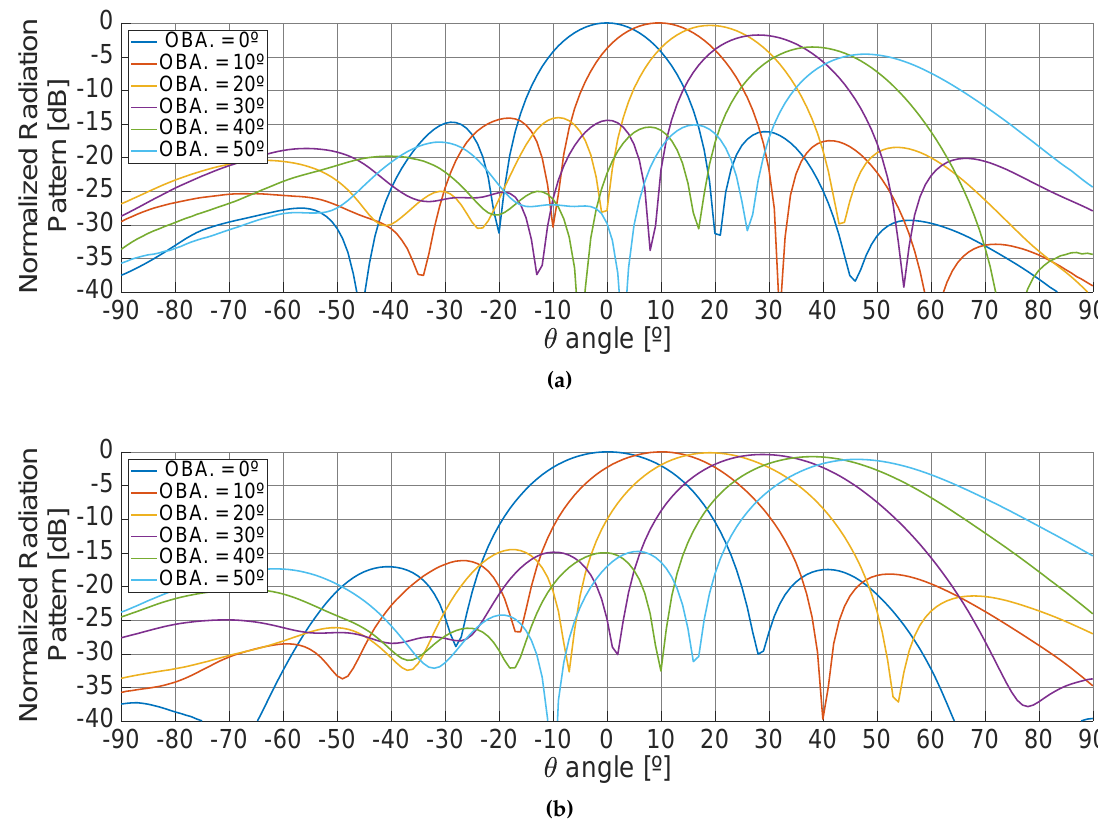
Figure 21. Planar cuts of the radiation pattern along the ϕ = 0 ◦ plane when tilting the beam in the same plane for different off-boresight pointing angles, at the L1/E1 ( a ) and L5/E5 ( b ) frequency bands.